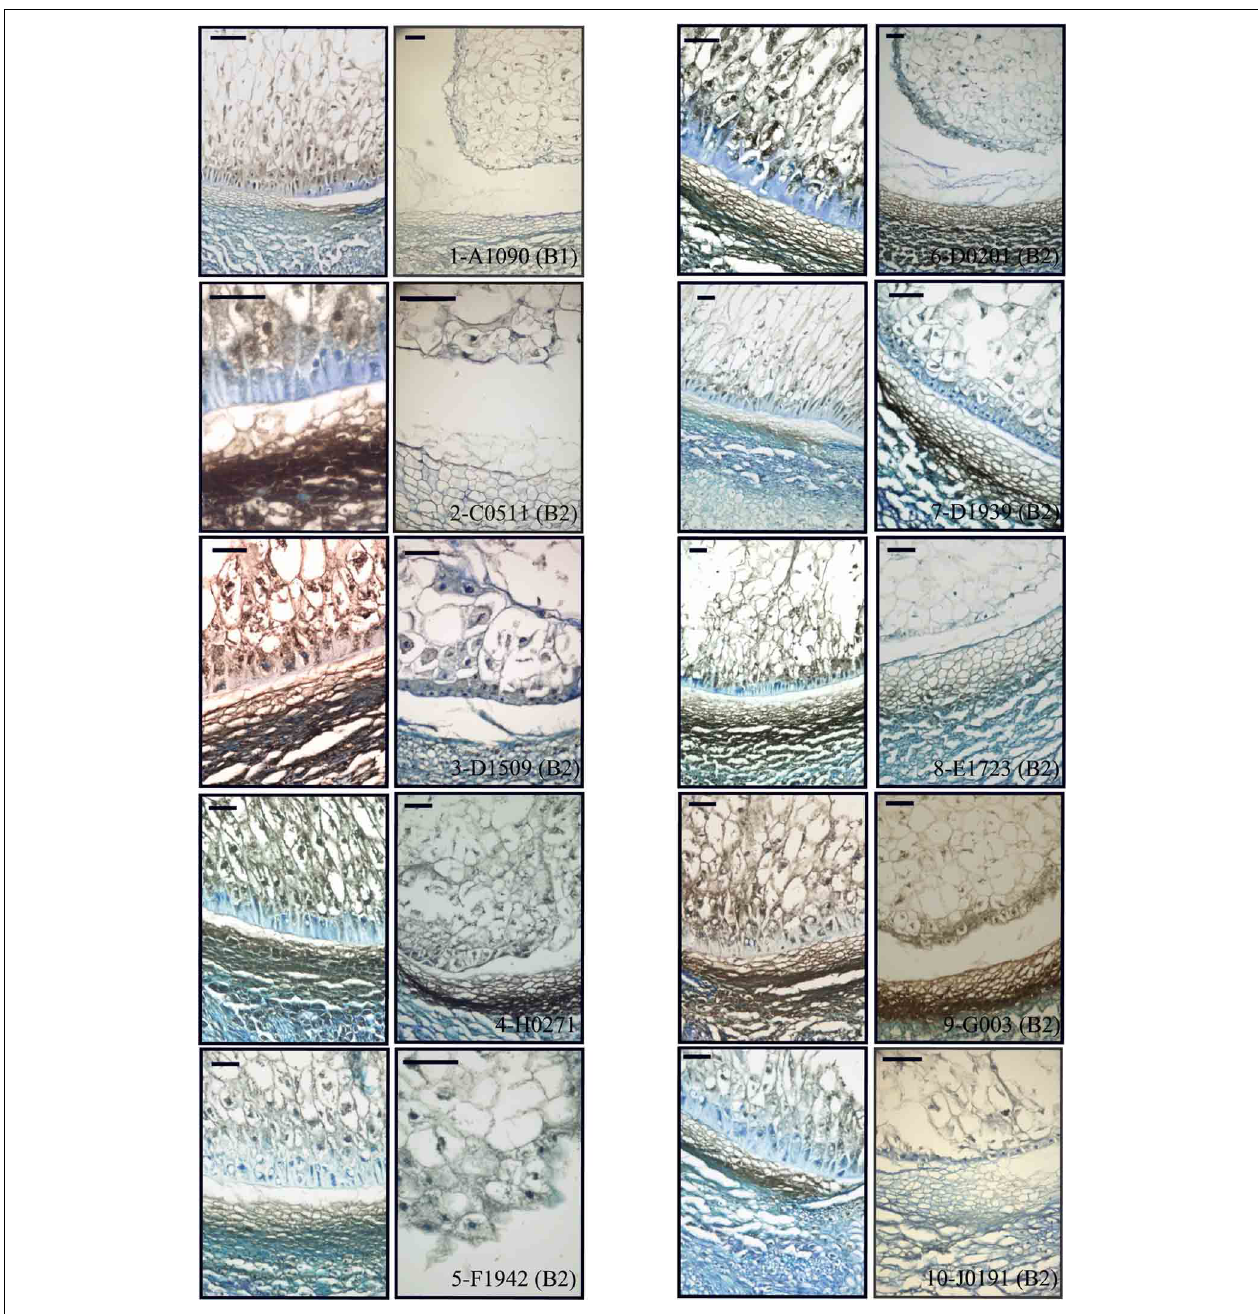
FIGURE 7 | Basal endosperm structure and immunodetection of BETL peptides. Sections of WT (first and third column) and mutant (second and fourth column) were reacted with antiBETL1 or antiBETL2 and counterstained with azure B. Scale bars represent 50 µ m.